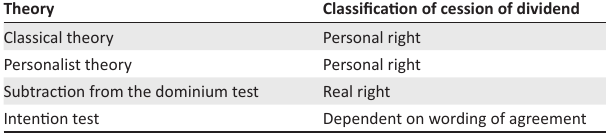
TABLE 1: Classification of the cession of a dividend as a real right or a personal